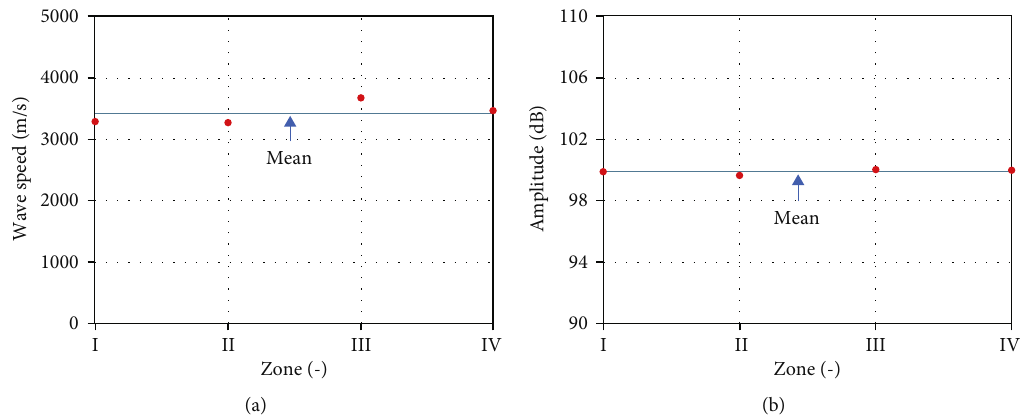
Figure 7: Intact sandstone dispersion plot. (a) Wave speed dispersion plot. (b) Amplitude dispersion Table 2: Experimental results of acoustic emission from fractured sandstone.